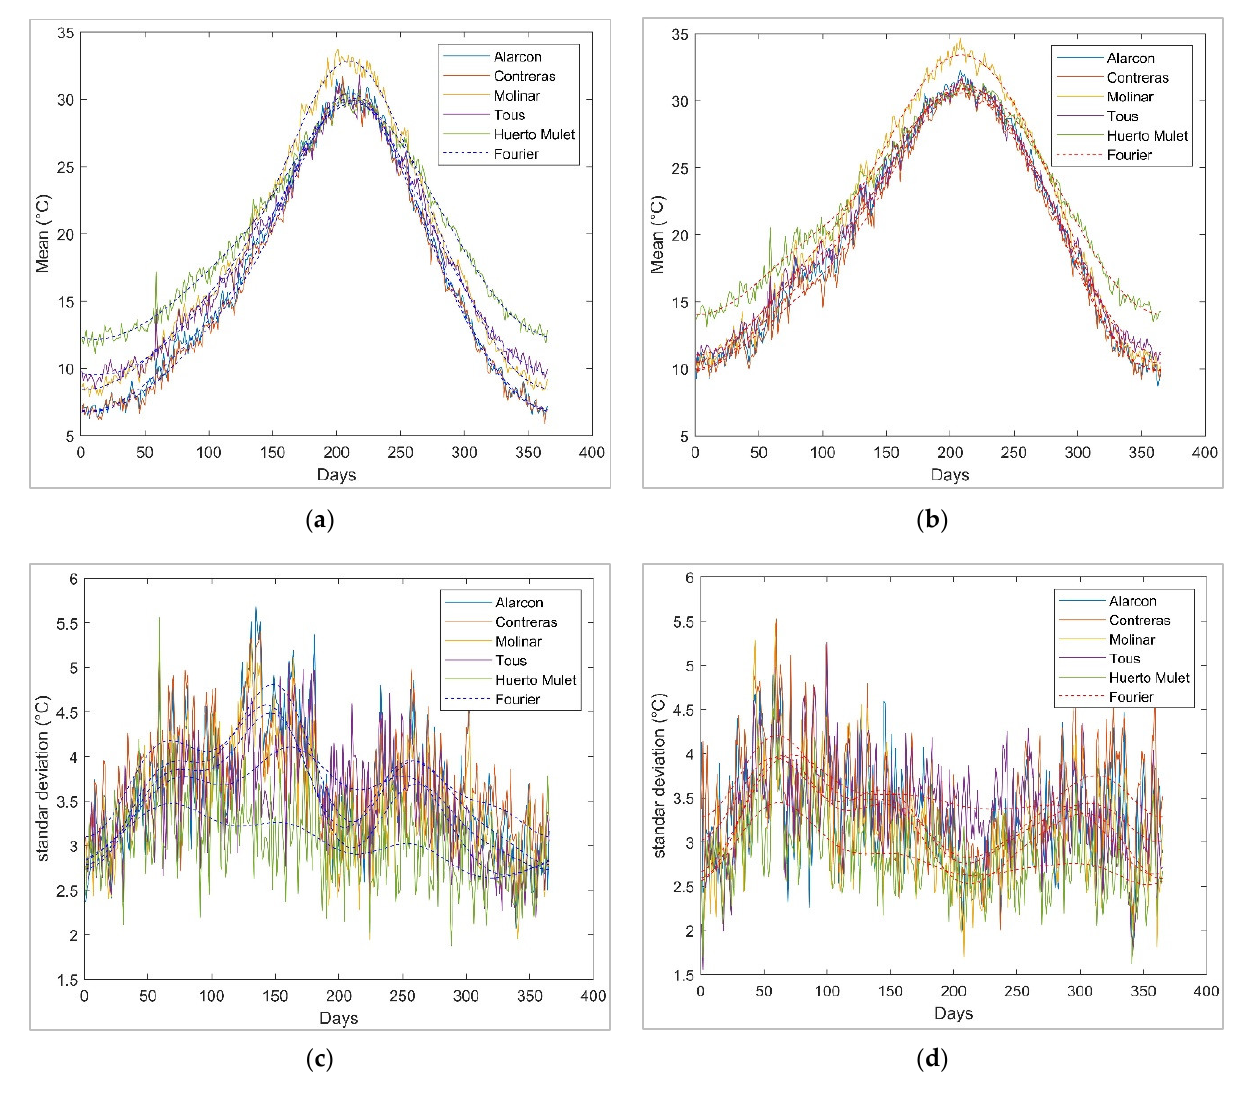
Figure 4. Skewness coefficient (daily average) of normalized series (66 years): ( a ) maximum temper- ature and ( b ) temperature range. Anderson confidence limits (95%).